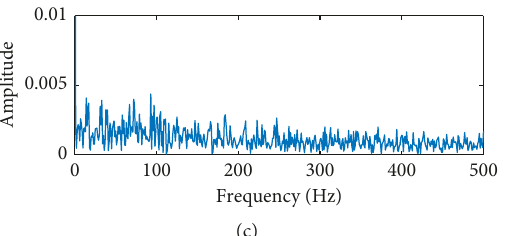
Figure 24: Diagnosis results of the life cycle fault signal by WPT-FSK: (a) kurtogram; (b) TW of the filtered signal with the maximal kurtosis; (c) ES of